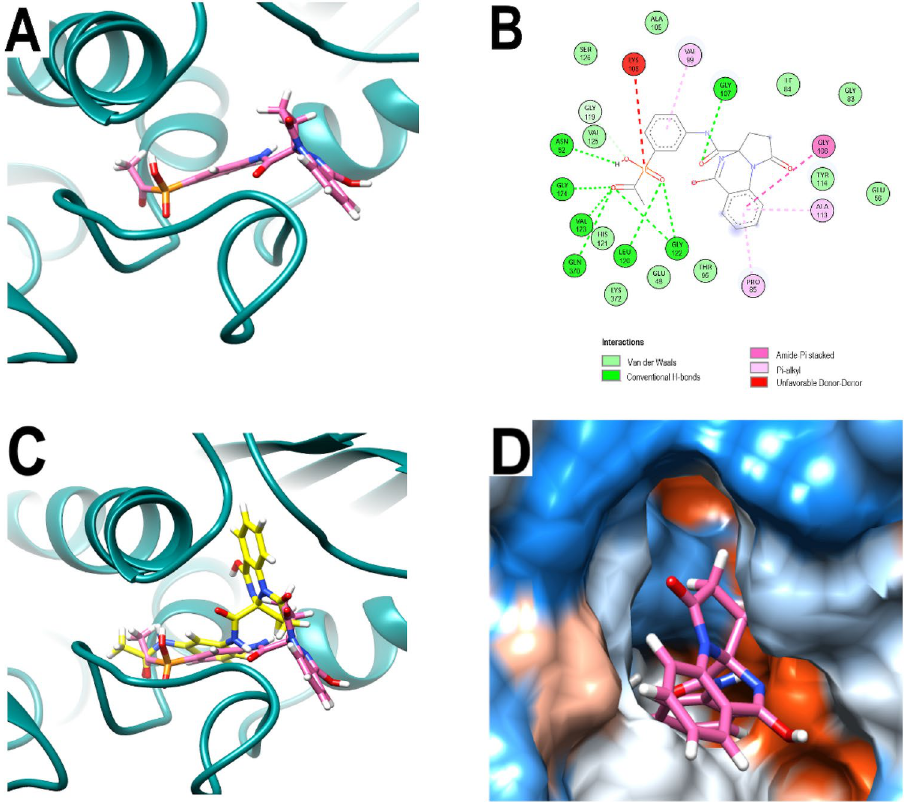
Figure 3. Analysis of the best-predicted docking pose of PQP. ( A ) 3D representation of 3ZKBL-PQP complex. ( B ) 2D interaction diagram of 3ZKBL-PQP complex. ( C ) 3D representation of 3ZKBL-PQP complex superimposed with PQd (yellow backbone). ( D ) Hydrophobic surface representation of 3ZKBL complexed with